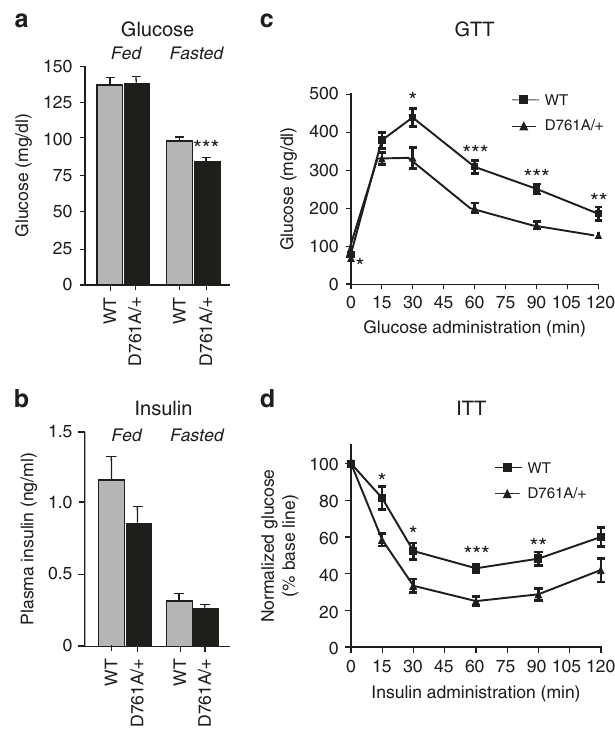
Fig. 2 Impact of Vps34 inactivation on glucose tolerance, insulin sensitivity in lean mice. a Serum glucose levels under randomly fed and fasted conditions. Data represent mean ± SEM (non-parametric Mann – Whitney t - test). b Serum insulin levels under randomly fed and fasted conditions. Data represent mean ± SEM (non-parametric Mann – Whitney t -test). c GTT after intraperitoneal injection of 2 g/kg of glucose in mice after overnight starvation. Data represent mean ± SEM (non-parametric Mann – Whitney t - test). d ITT after intraperitoneal injection of 0.75 U/kg of insulin in mice after overnight starvation. Data represent mean ± SEM (non-parametric Mann – Whitney t -test). For all experiments shown, ≥ 10